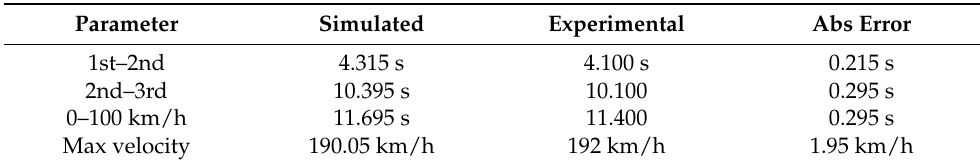
Table 2. Results in maximum acceleration